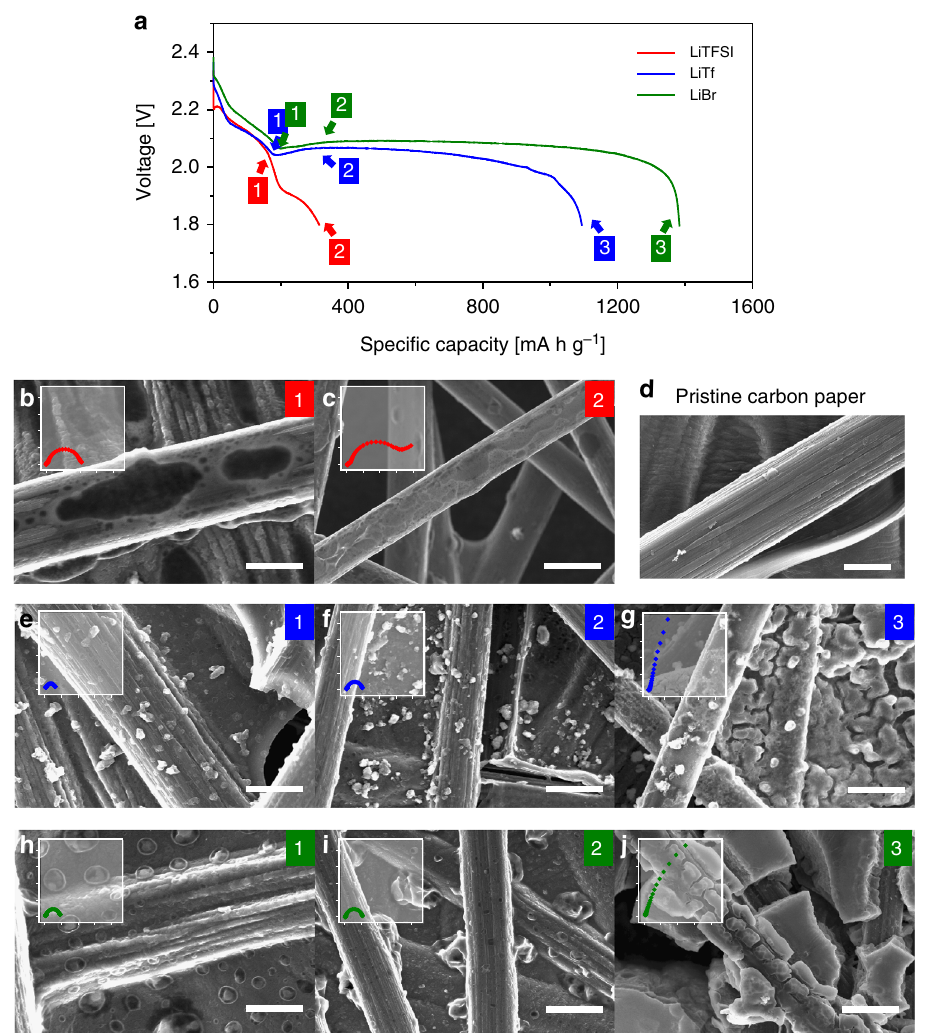
Fig. 2 Morphological evolutions of lithium sul fi de at different states of discharge. a The fi rst discharge curves at 0.05 C. Discharge of the individual cells stopped at the marked states of discharge (SOD) for Scanning electron microscopy (SEM) analysis. d A SEM image of the pristine carbon paper (CP) electrode, SEM images of the CP electrodes at different SODs with the b , c lithium bistri fl imide (LiTFSI), e – g lithium tri fl ate (LiTf), and h – j lithium bromide (LiBr) electrolytes. Scale bars, 5 μ m ( b , d , e , h ); 10 μ m ( c , f , g , i , j ). The Nyquist plots of the impedances measured at the points are provided in the insets. (The range of the x and y -axes is from − 100 to 1400 Ω cm 2 ; enlarged fi gures are given in Supplementary Fig.